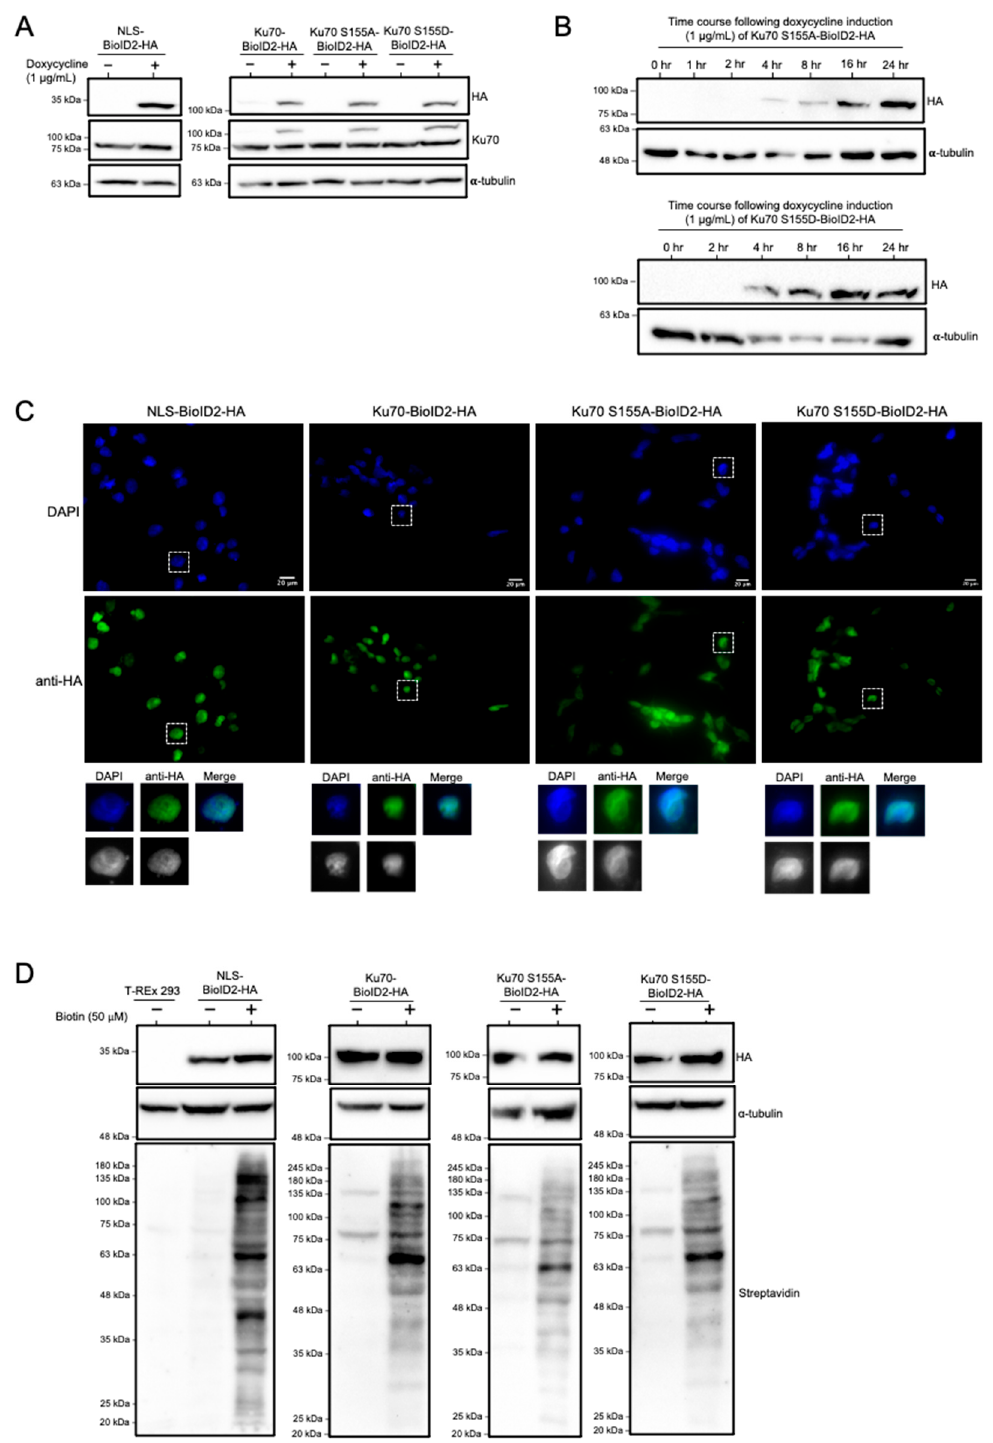
Figure 1. Creating and testing inducible, stable Ku70-BioID2 Flp-In TM T-REx 293 cell lines. All Western blots depicted show 50 µg of whole cell extracts (WCE). Western blots were probed with HA, Ku70, and α -tubulin antibodies, and a HRP-streptavidin probe: ( A ) cell lines induced with or without 1 µg/mL doxycycline for 24 h before analyzing by Western blotting; ( B ) time course experiment to determine optimal expression time point of stable cell lines induced with 1 µg/mL doxycycline using Ku70 S155A-BioID2-HA and Ku70 S155D-BioID2-HA stable cell lines; ( C ) indirect immuno- fl uorescence of BioID2 T-REx 293 stables cell lines induced with 1 µg/mL doxycycline for 24 h, using HA antibody, imaged at 488 nm wavelength. Images were taken at 20× magni fi cation and the white line denotes 20 µm. Below, cropped enlargements of individual cells are shown either colored or in